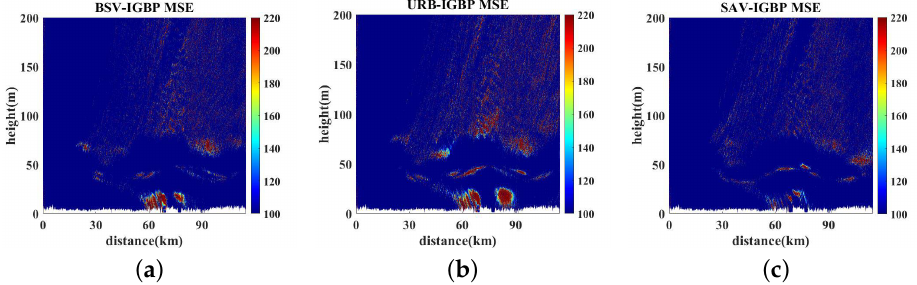
Figure 20. The MSE of PL using the improved TWPE between IGBP LC and different LCs, on Shanghai–Wuxi. ( a ) BSV-IGBP MSE of PL on S–W. ( b ) URB-IGBP MSE of PL on S–W. ( c ) SAV-IGBP MSE of PL on